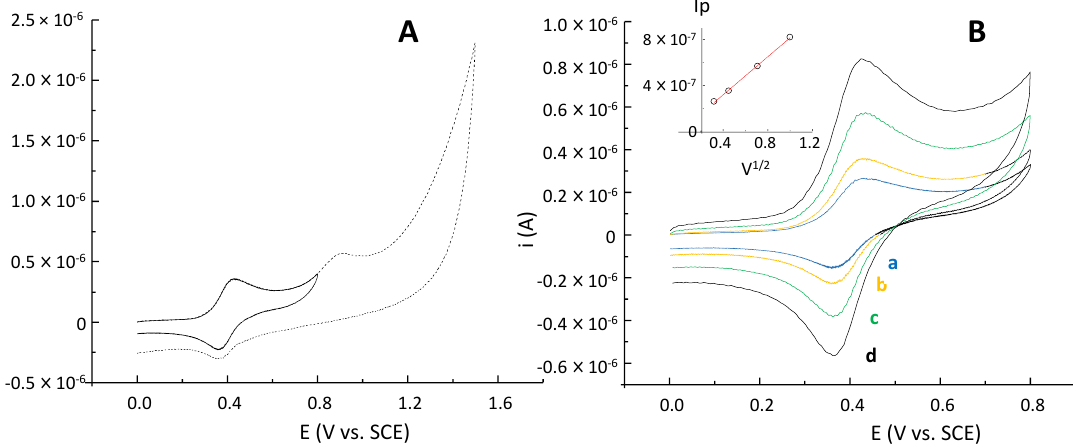
Figure 2. Cyclic voltammograms (CVs) of P797 (1 mmol.dm − 3 ). ( A ) CVs of P797 in acetonitrile (solid line); in acetonitrile + TBABF 4 0.1 mol.dm − 3 (dotted line) at a Pt disk electrode (diam 0.5 mm). Scan rate: 0.1 V.s − 1 ; ( B ) CVs of P797 (1 mmol.dm − 3 ) at different scan rates: 0.1 V.s − 1 (a), 0.2 V.s − 1 (b), 0.5 V.s − 1 (c), 1 V.s −1 (d). Inset: variation of the oxidation peak current with the square root of the scan rate.